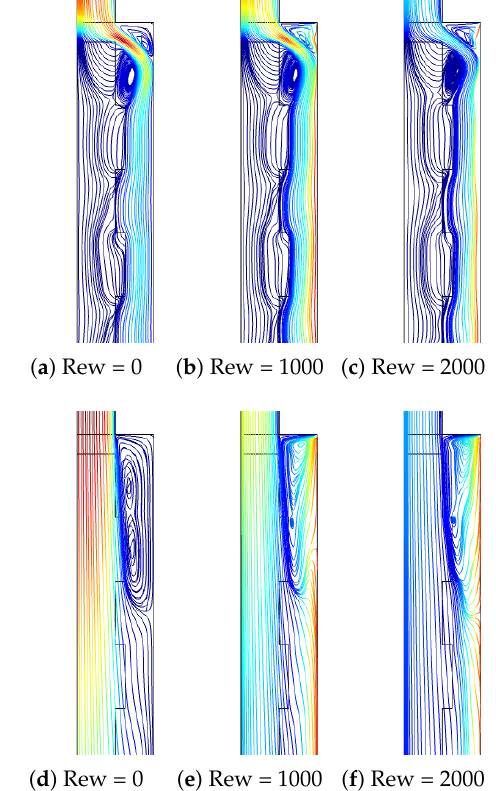
Figure 7. Effectsof Rew on F-P variations at two different permeabilities of the PL (( a – c ), Da = 10 − 5 ), (( d – f ), Da = 10 − 1 ) (Re = 250, Ha = 7.5, ax = 0.25 ap, N =